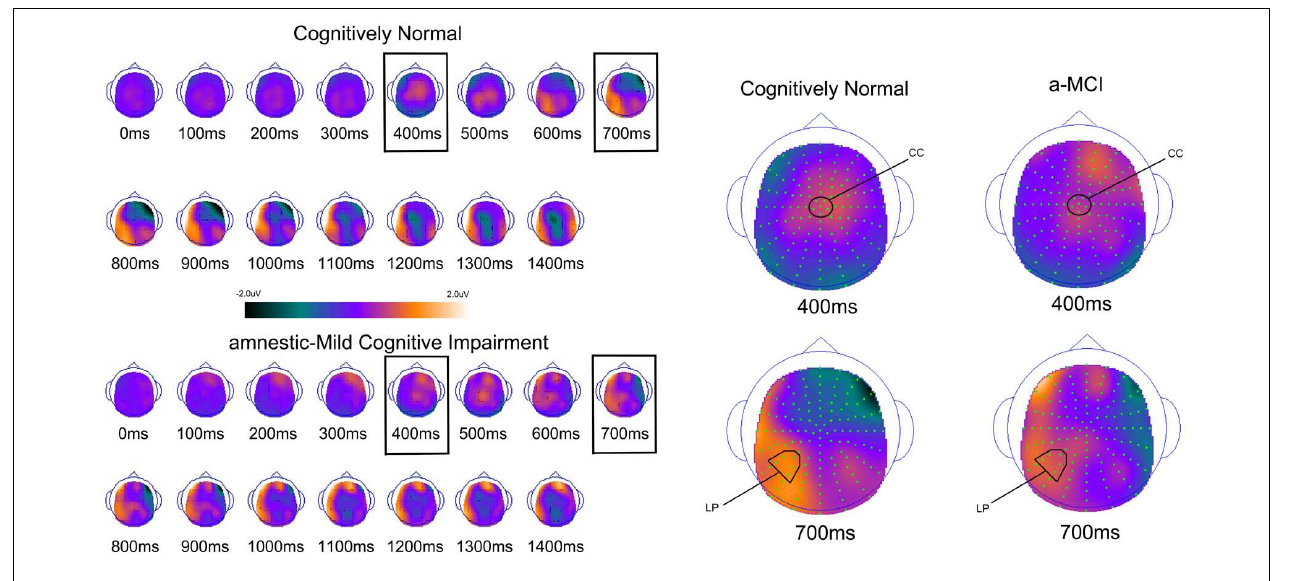
FIGURE 3 | Scalp topography maps for CN adults and patients with amnestic mild cognitive impairment for retrieval success effects (hits minus correct rejections) matched for performance. Highlighted